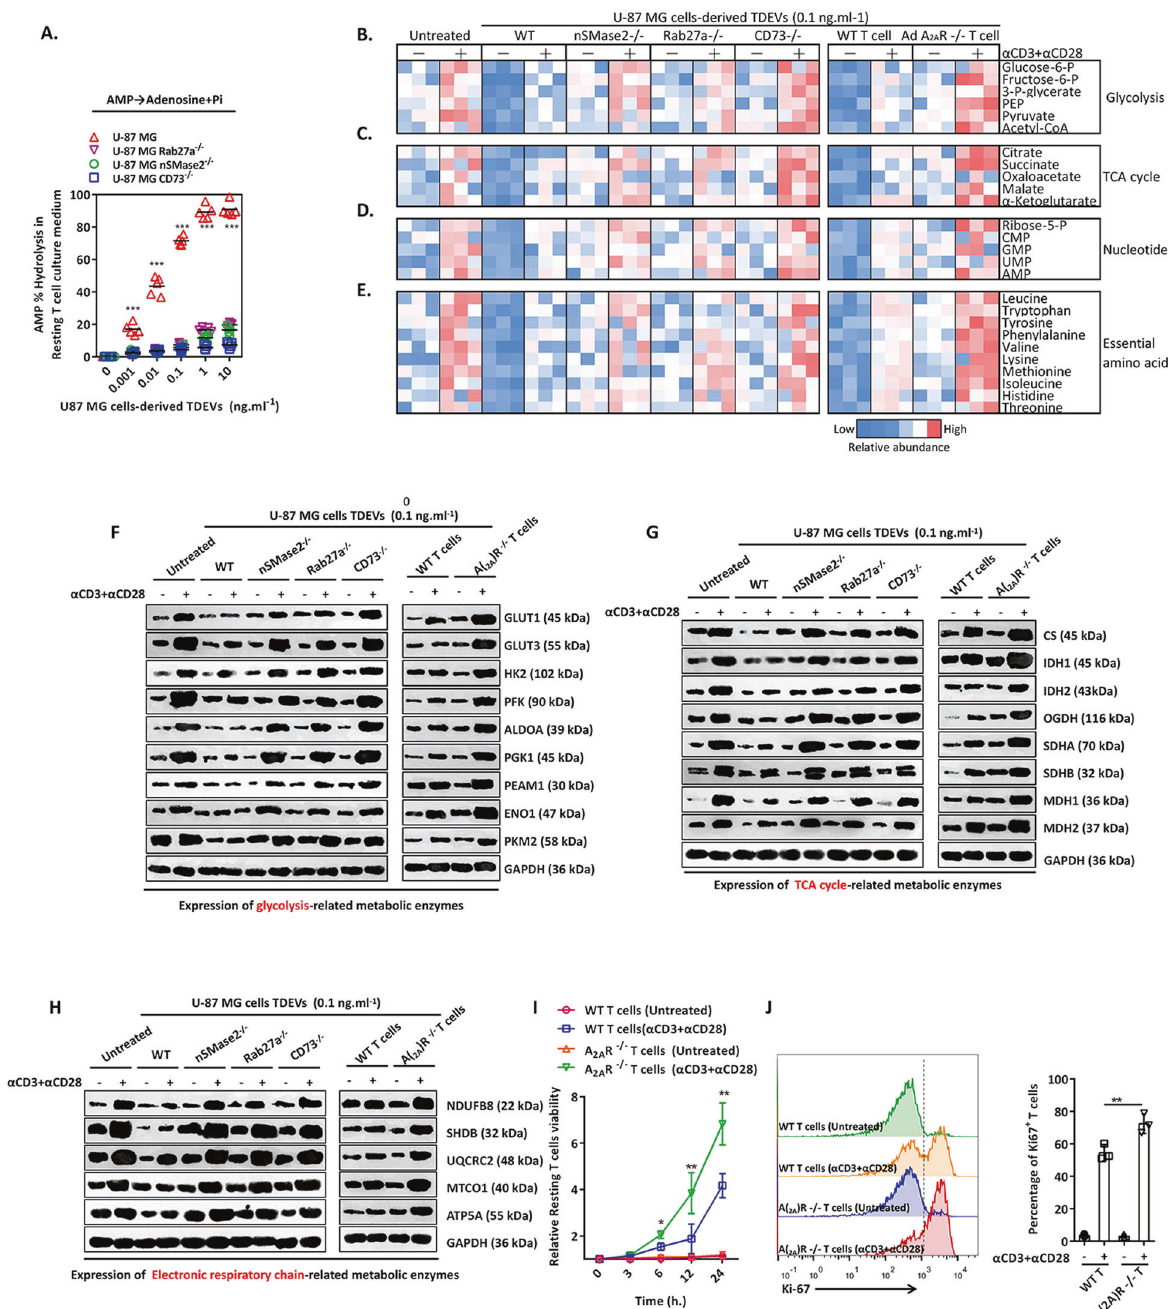
Fig. 4 CD73-positive TDEVs inhibit T-cell aerobic glycolysis in an adenosine – A 2A R-dependent mechanism. A Adenosine level was detected by ELISA in culture medium from T cells cocultured with TDEs from WT, nSMase2 − / − , Rab27a − / − and CD73 − / − U-87 MG GBM cells ( n = 5). B – E The relative abundance of polar metabolites from glycolysis and TCA cycle, nucleotides and essential amino acids was detected by liquid phase-mass spectrometry in T-cell lysates exposed to TDEs from WT, nSMase2 − / − , Rab27a − / − and MG CD73 − / − U-87 GBM cells in the presence or absence of α CD3 + α CD28 ( n = 3). F – H Representative immunoblot of the expression of metabolic enzymes related to glycolysis, the TCA cycle and electron transport chain as detected by western blotting in T-cell lysates supplemented with TDEs from WT, nSMase2 − / − , Rab27a − / − and CD73 − / − U-87 MG GBM cells in the presence or absence of α CD3 + α CD28. I The viability of WT and A 2A R − / − T cells was detected in the presence or absence of α CD3 + α CD28. J Ki-67 expression was detected in WT and A 2A R − / − T cells in the presence or absence of α CD3 + α CD28. Data are shown as the mean ± SD; t test, * p < 0.05 and ** p < 0.01 compared to unstimulated T cells. All data are from three independent experiments ( F – J are taken up by T-lymphocytes. Importantly, coculture of CD73 + TDEVs with T cells attenuated the T-cell clonal proliferation induced by α CD3 + α CD28. It is well known that T-lymphocytes undergo clonal proliferation when antitumour immunity is activated.